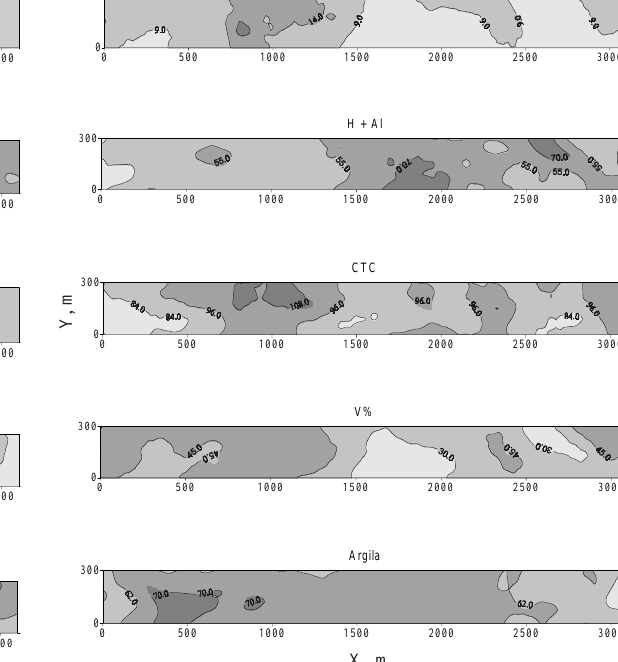
Figura 1. Mapas de isolinhas dos atributos P, MO, pH, K + e Ca 2+ , na profundidade de 0,00–0,20